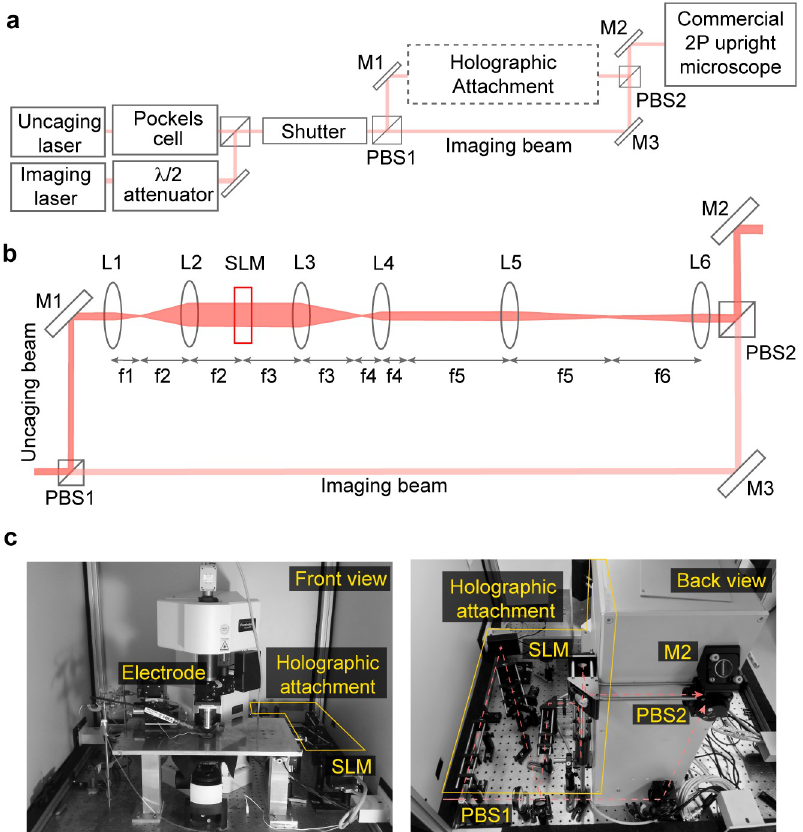
Fig 1. Optical setup of holographic projector attachment. a : Schematic of the commercial two-photon microscope and the holographic attachment. b : Detailed schematic of the holographic projector attachment. PBS: polarizing beam splitter, M: mirror, L: lens, SLM: spatial light modulator, λ /2: half waveplate. H1: conjugate image of the SLM hologram (H0). Lenses: f 1 = f 4 = 30 mm; f 2 = f 3 = 100 mm; f 5 = f 6 = 500 mm. c : Photographs of the setup showing the front view of the commercial microscope (left), and the back view showing the holographic attachment (right).